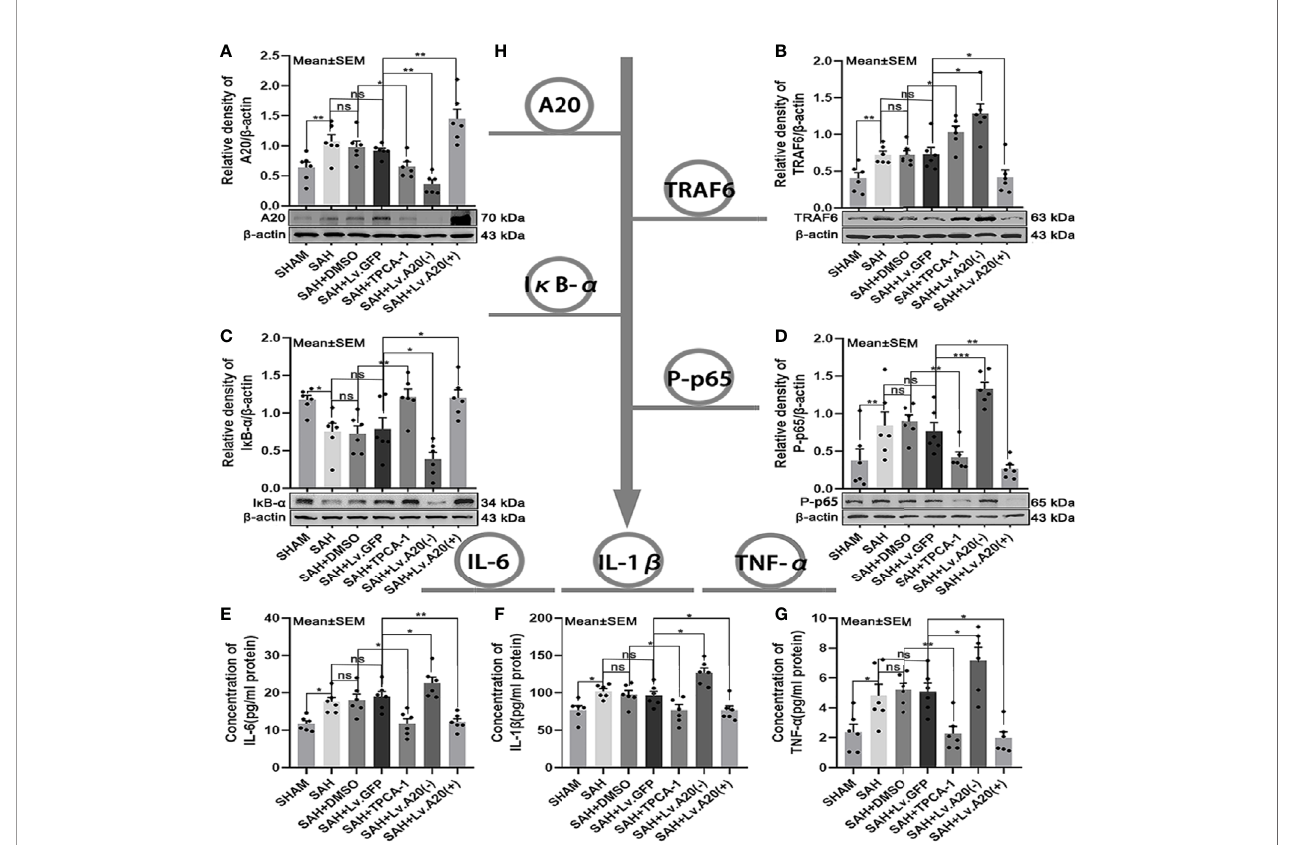
FIGURE 3 | A20 negative feedback regulates the NF- k B A20/TRAF6/NF- k B signaling pathway. (A-D) Immunoblotting of A20, TRAF6, I k B- a , and phosphorylated (P)-p65 in brain tissue after treatment with TPCA-1 and lentivirus demonstrated a negative feedback loop between A20 and NF- k B. (E-G) ELISA of in fl ammatory cytokines — IL-6, IL-1 b , and TNF- a . Administration of TPCA-1 and lentivirus knockdown inhibited the expression of the in fl ammatory cytokines. The administration of TPCA-1 and lentivirus to induce overexpression of A20 inhibited the release of in fl ammatory cytokines, and in fl ammatory cytokine levels were elevated by A20 knockdown. (H) Tree diagram of the A20/TRAF6/NF- k B signal pathway. Data are expressed as mean ± SEM, n = 6, * p < 0.05, ** p < 0.01, *** p < 0.005, ns versus SAH. ns, non-signi fi